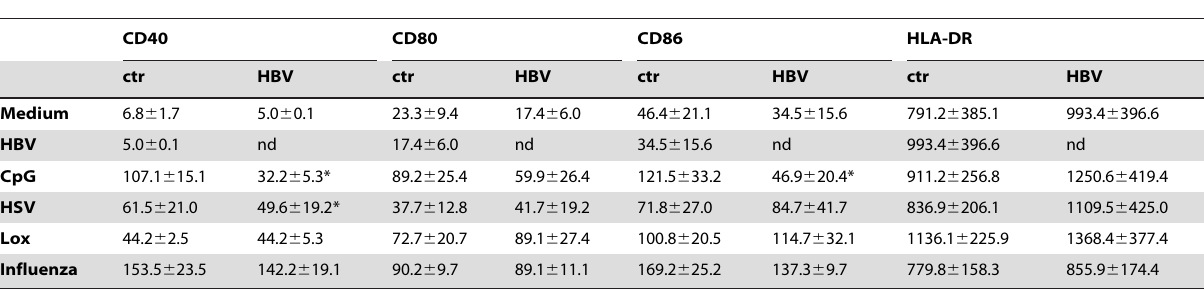
Table 1. Effect of HBV on pDC